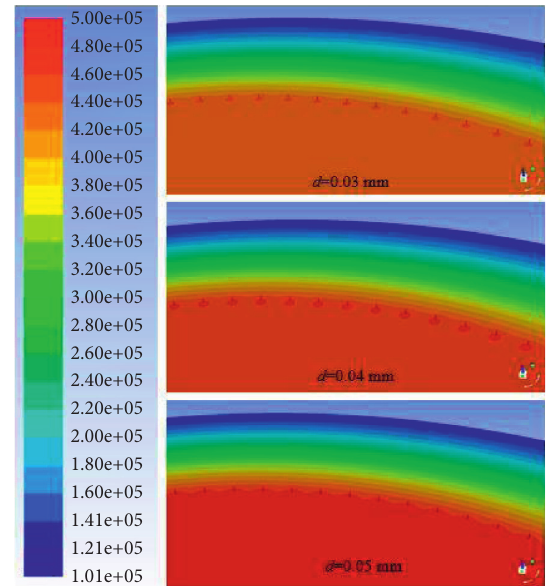
Figure 6: Air film pressure distribution of bearings with